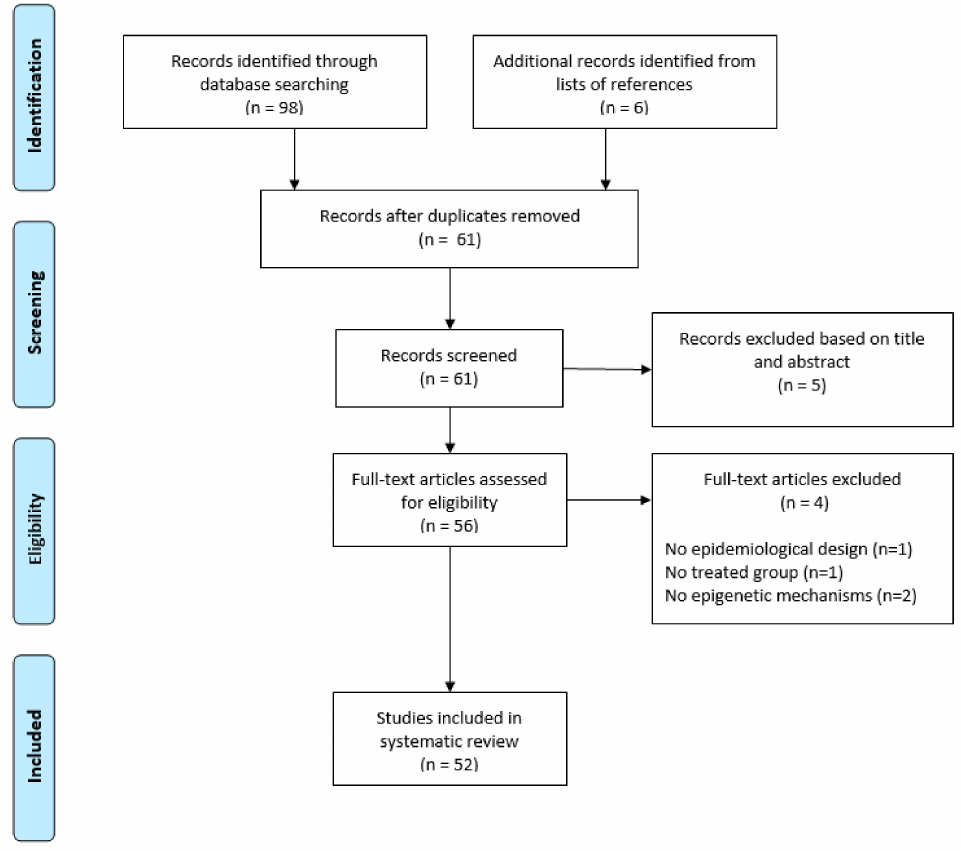
Figure 1. PRISMA 2009 Flow Diagram of study